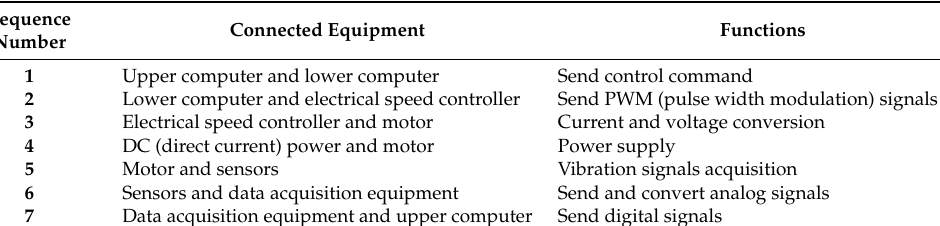
Figure 7. Experimental setup. Table 2. Connections between equipment.